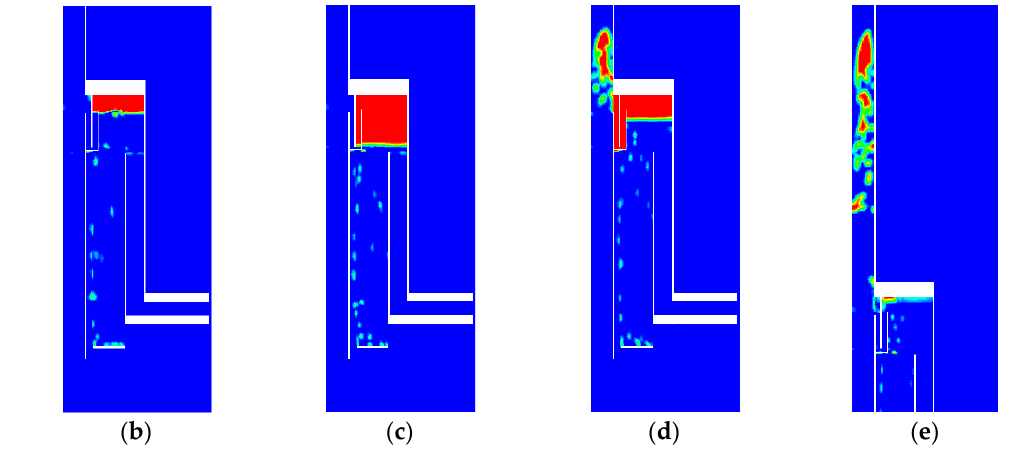
Figure 6. Generation process of the air piston inside the water-lifting aerator (WLA). ( a ) t = 27 s, ( b ) t = 77 s, ( c ) t = 214 s, ( d ) t = 218 s, and ( e ) t = 220 s.